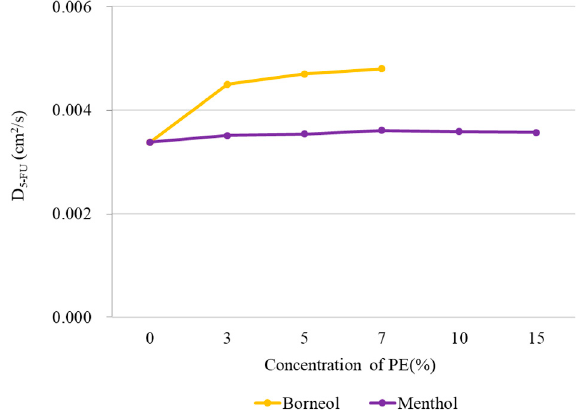
Figure 4. Diffusion coefficient of 5-FU along the z -axis at different PE concentrations obtained from CG MD. The application of high borneol concentration resulted in the disruption of membrane structure, so no meaningful diffusion coefficient for 5-FU could be calculated for borneol concentrations >10%.